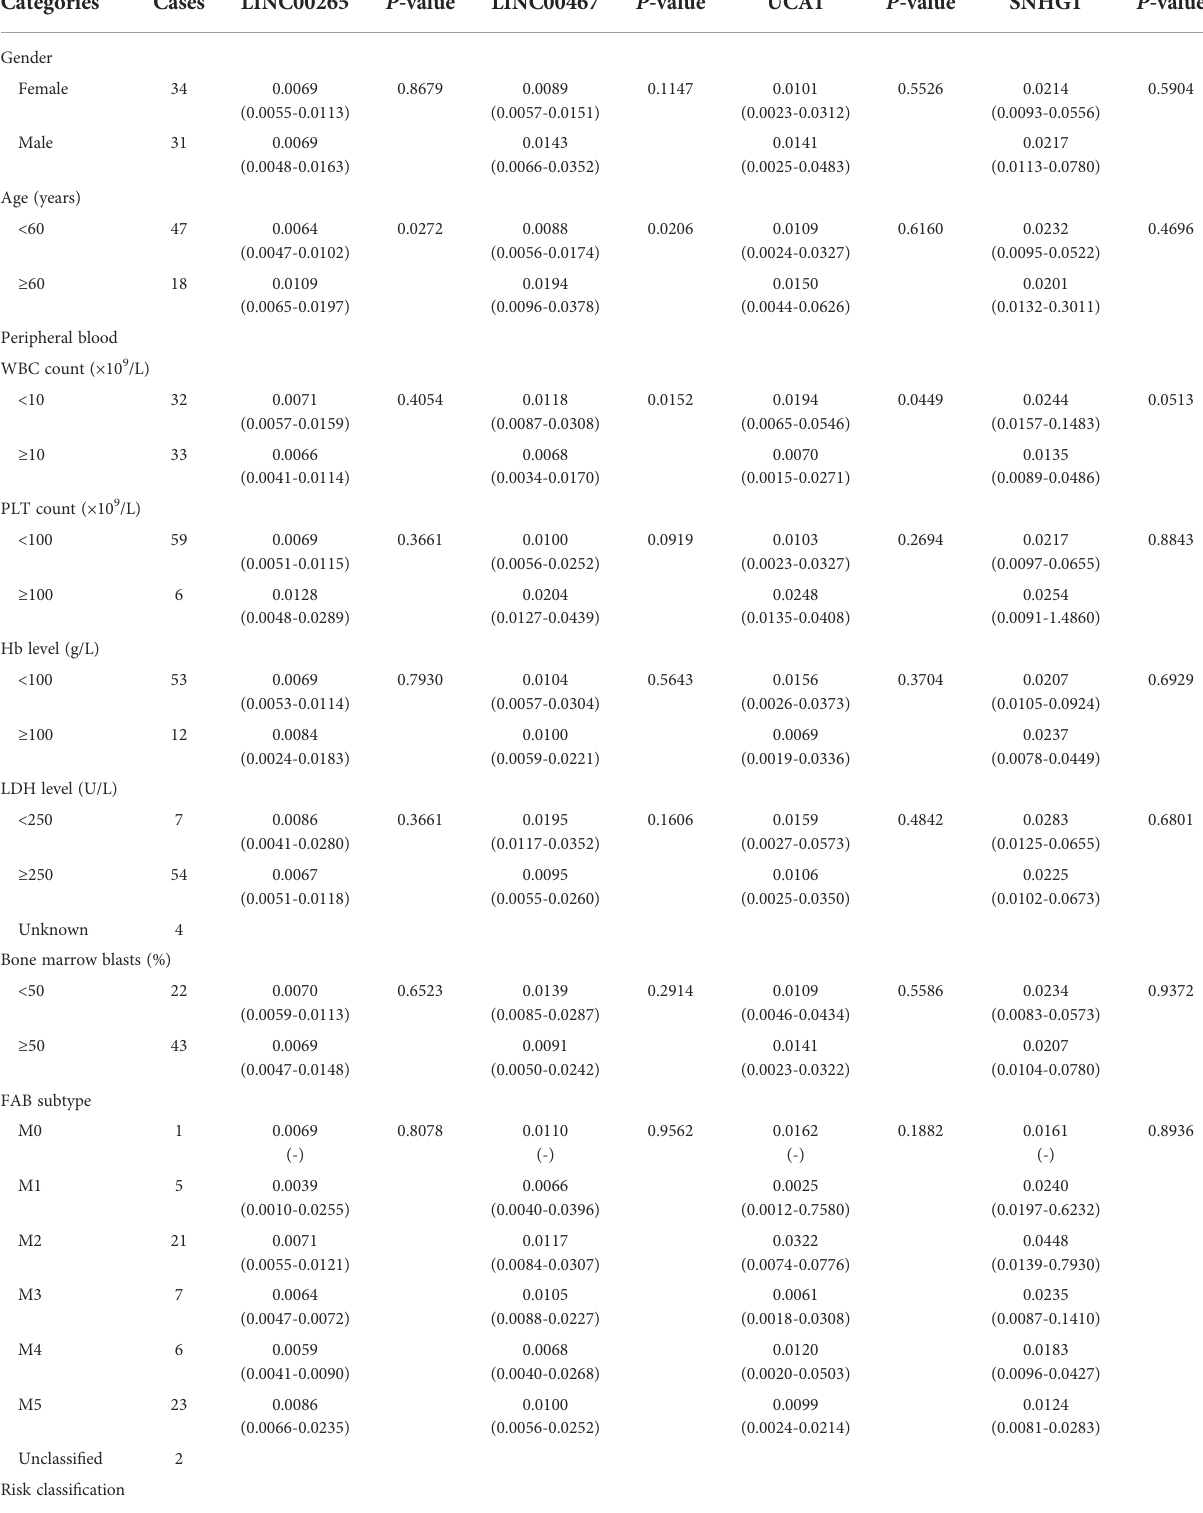
TABLE 3 Correlation between the plasma exosomal lncRNA level and clinical characteristics of patients with AML (n = 65) [median